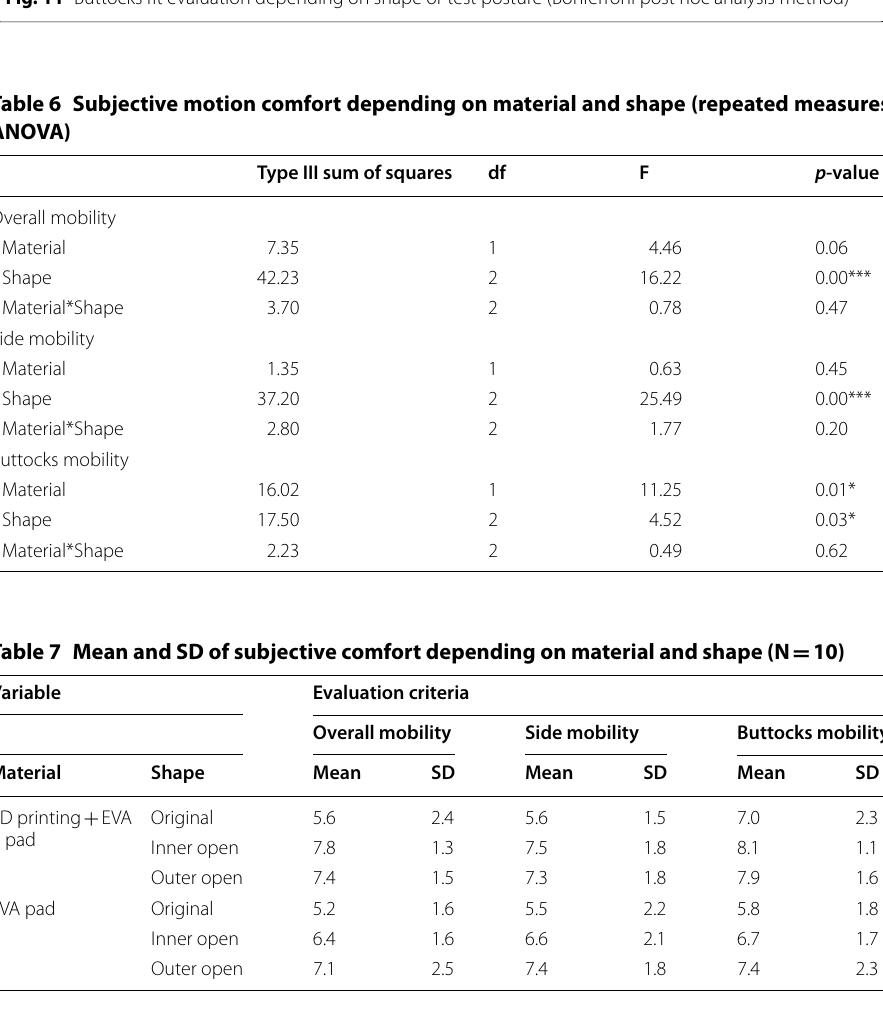
Fig. 11 Buttocks fit evaluation depending on shape or test posture (Bonferroni post hoc analysis method)